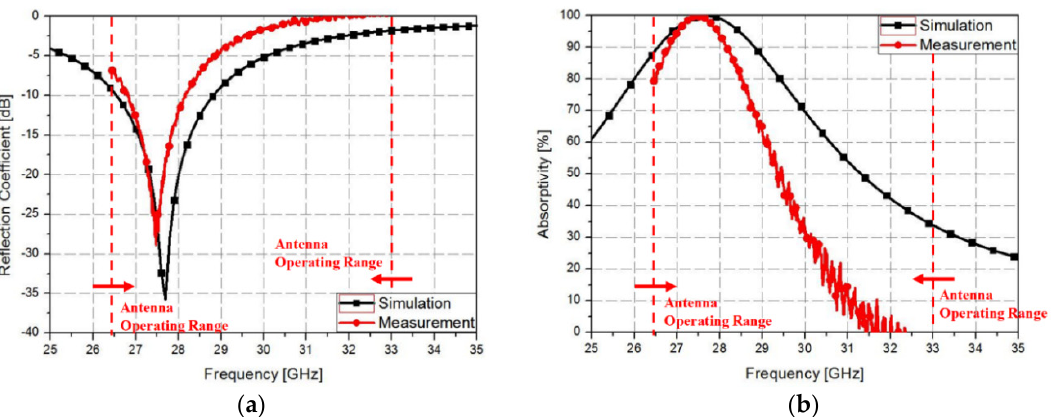
Figure 9. Comparison graph between simulation and measurement results: plots of ( a ) reflection coefficient and ( b ) absorptivity versus the frequency.